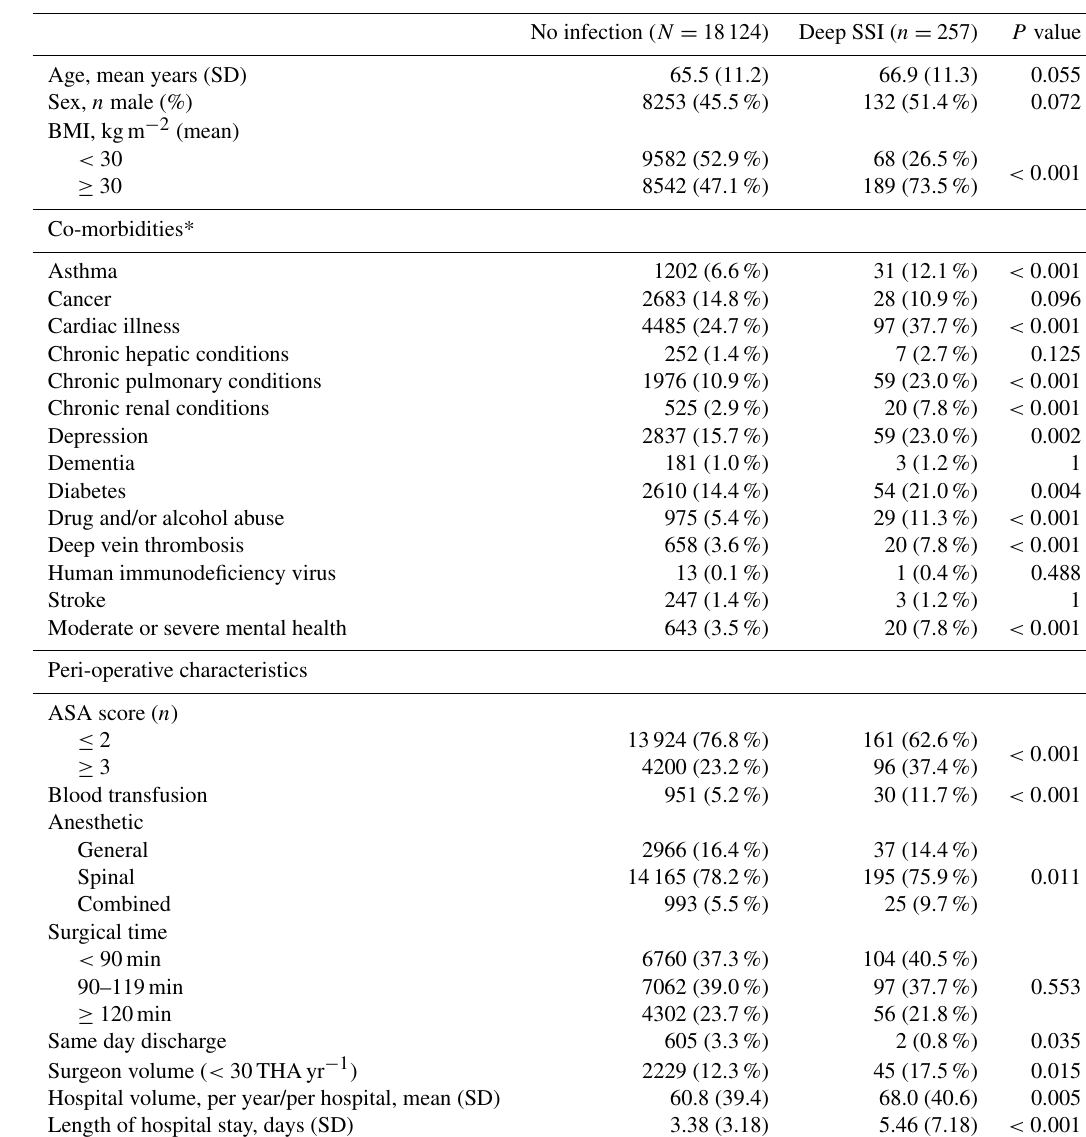
Table 3. Patient demographics and surgery